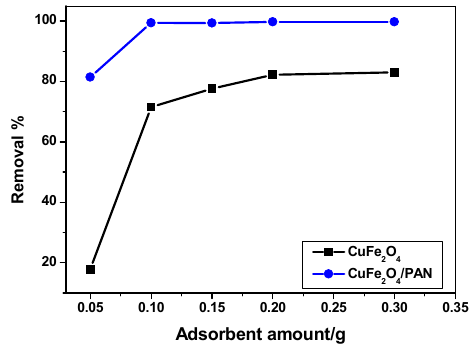
Figure 6. E ff ect of CuFe 2 O 4 and CuFe 2 O 4 / PANI nano-composite sorbents amount on adsorption optimization (V = 30 mL, Hg 2 + concentration = 25 µ g / mL, contact time = 2 h for CuFe 2 O 4 and 1 h for CuFe 2 O 4 / PANI and pH